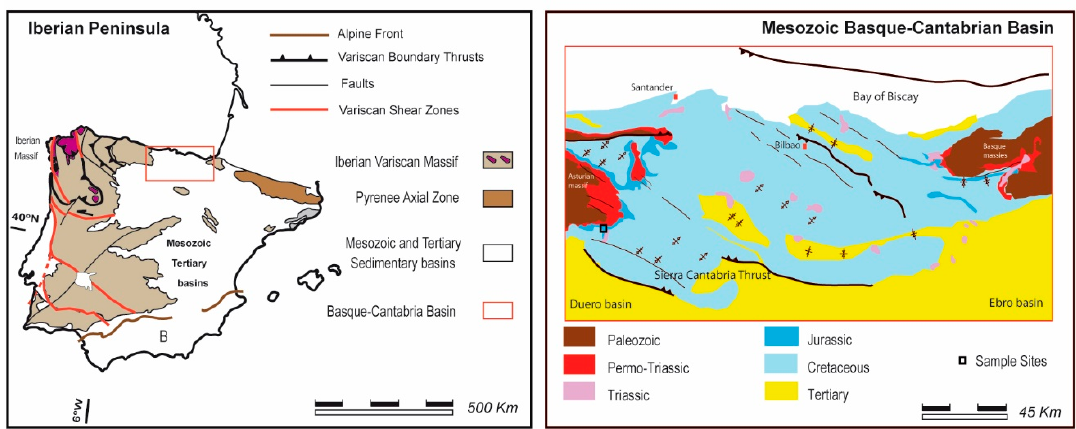
Figure 1. Location of study area with basic geological information. Modified after [33].